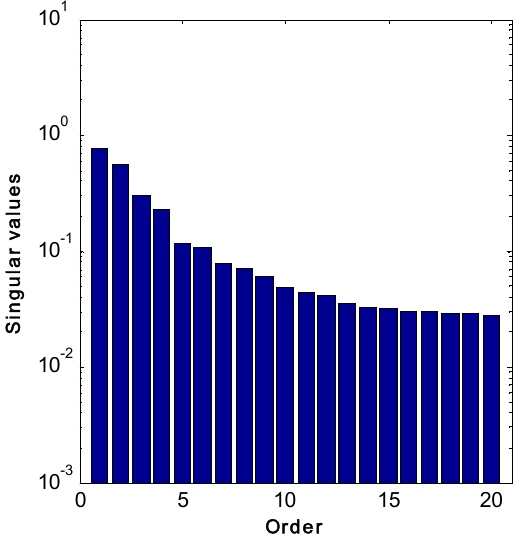
Figure 2. Singular values of the matrix Z , Equation (3), resulting from input/output data collected for a 5 × 5 fluidized catalytic cracking (FCC) system excited by PRBS inputs.